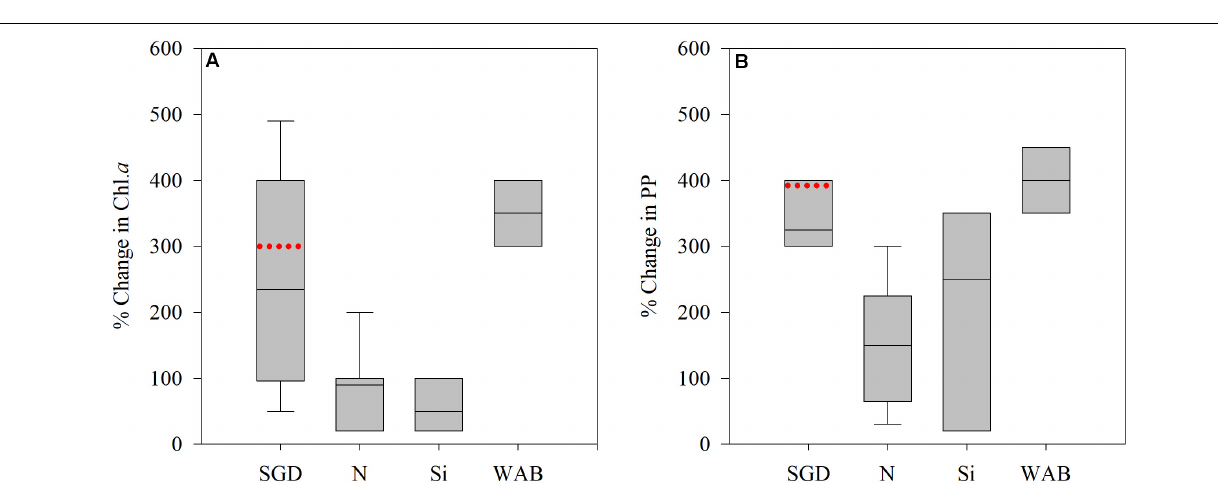
FIGURE 7 | Literature compilation showing the% change in chlorophyll a (Chl a ) (A) primary productivity (PP) (B) attributed to SGD, NO 3 (N), Si(OH) 4 (Si), or well-amelioration brines (WAB, containing mostly high levels of nitrate and silica). Data taken from De Sieyes et al. (2008), Garcés et al. (2011), Lecher et al.